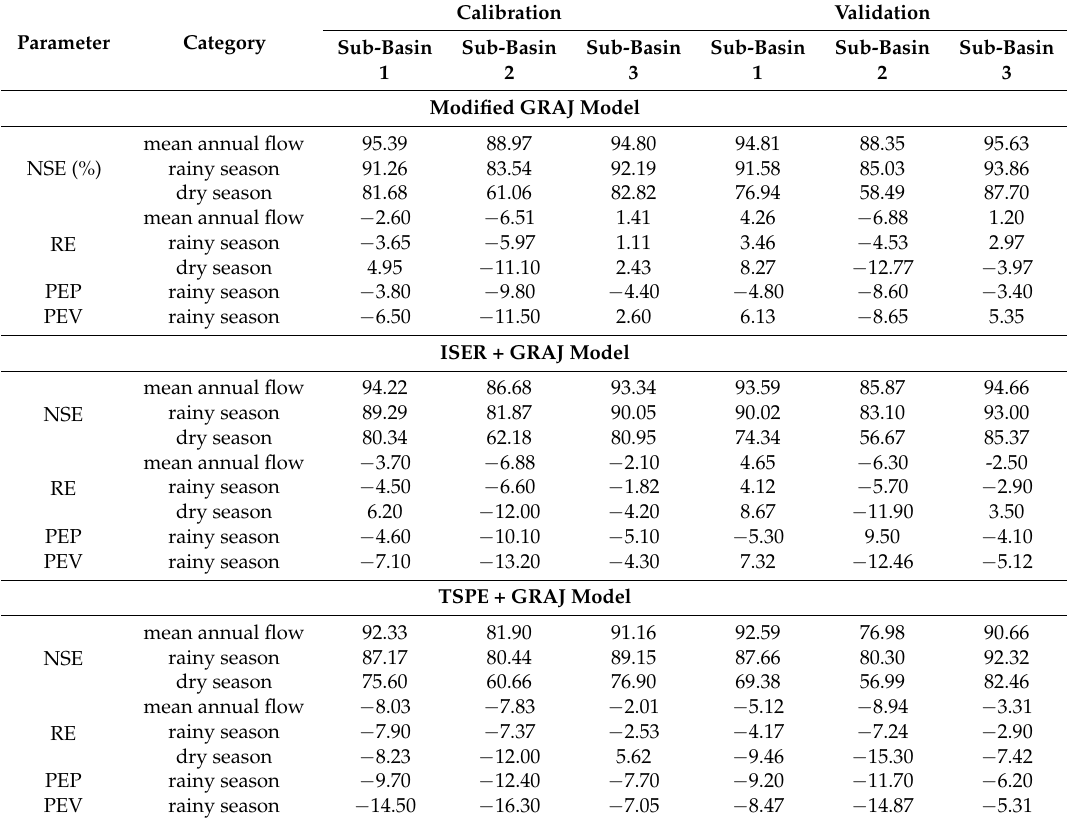
Table 3. Performances of the three sub-basins in the modified GXAJ model, ISER + GRAJ model, and TSPE + GRAJ model